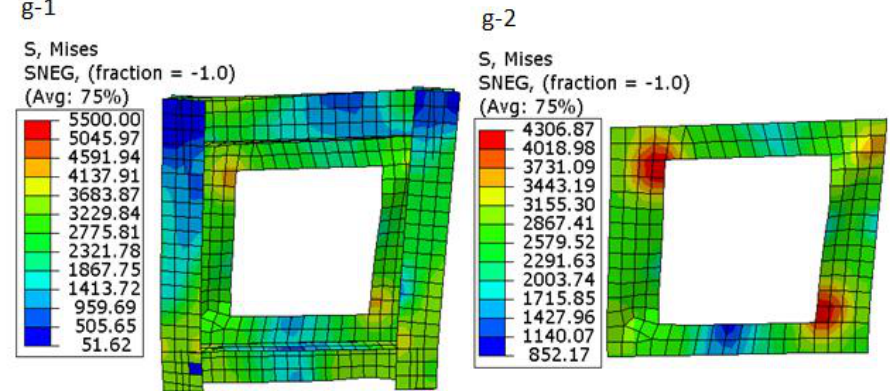
Figure 21. Load-displacement curves of specimens with different number of opening model (g–k).